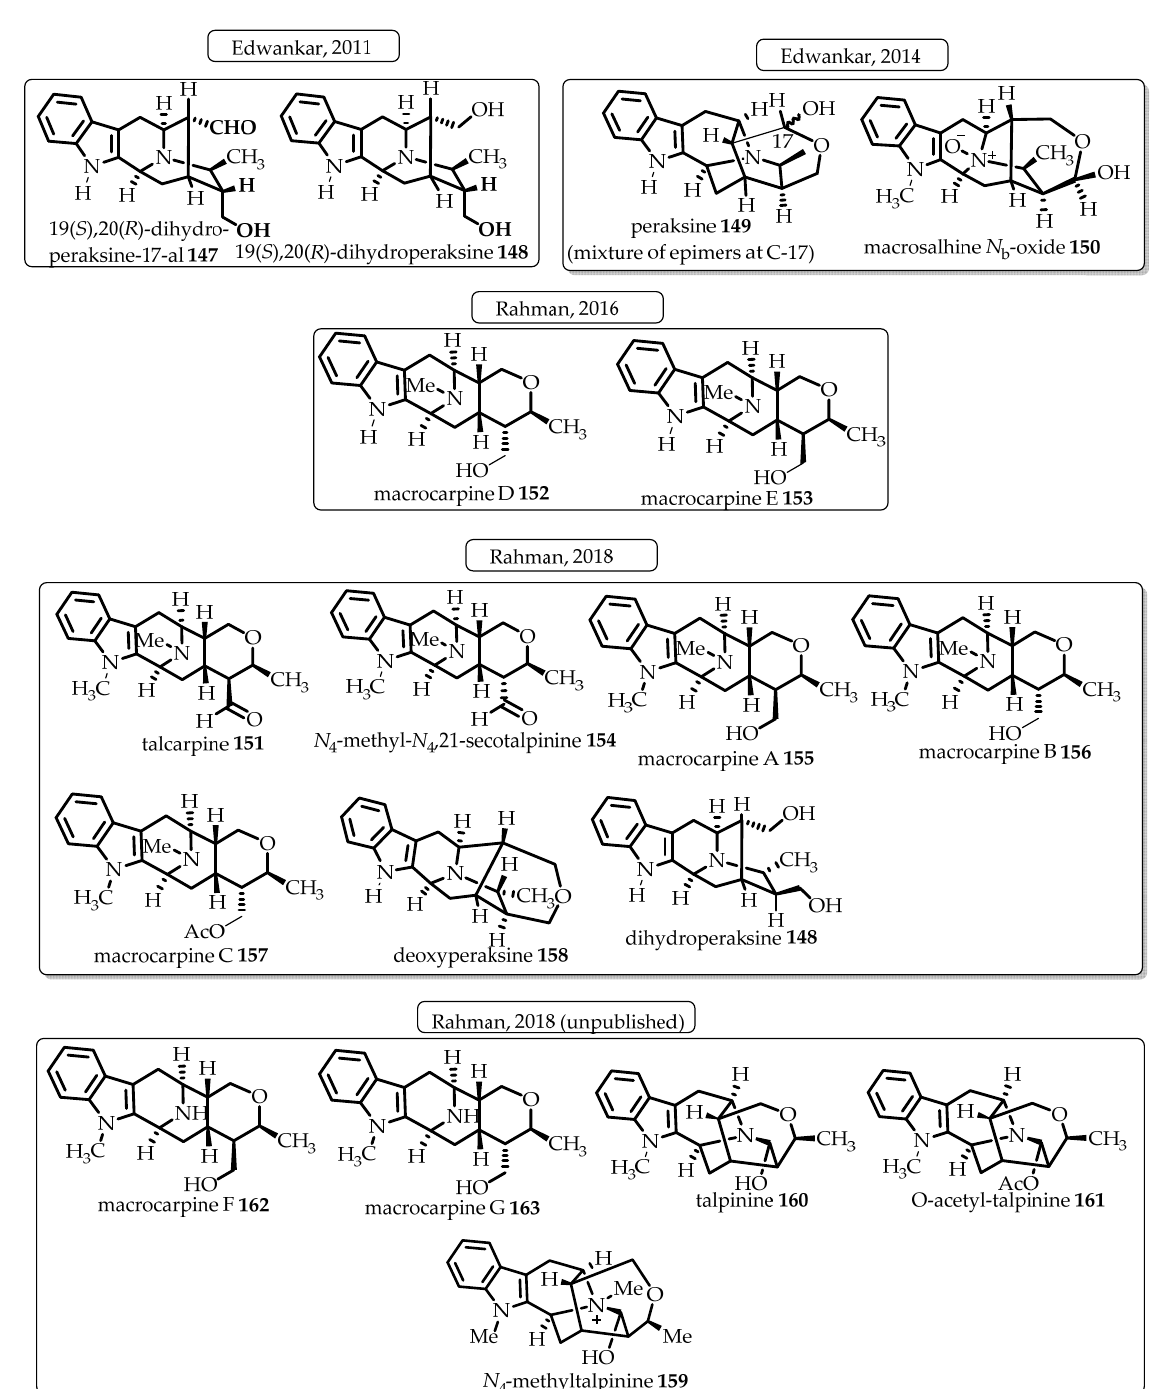
Figure 9. Examples of C-19 methylated alkaloids synthesized employing the general strategy developed herein